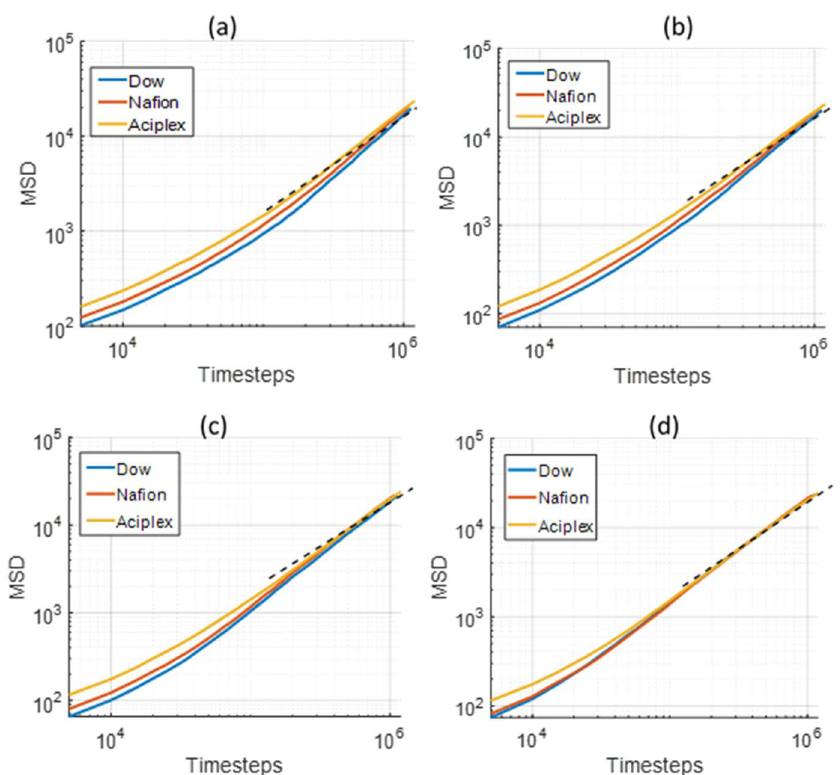
Figure 11. Comparison of the mean square displacement (MSD) of water for different side-chain length PEMs in four different layers at distances ranging from ( a ) 0–8 DPD units, ( b ) 8–16 DPD units, ( c ) 16–24 DPD units, and ( d ) 24–32 DPD units from the bottom Z boundary. The dotted line shows the unit slope.